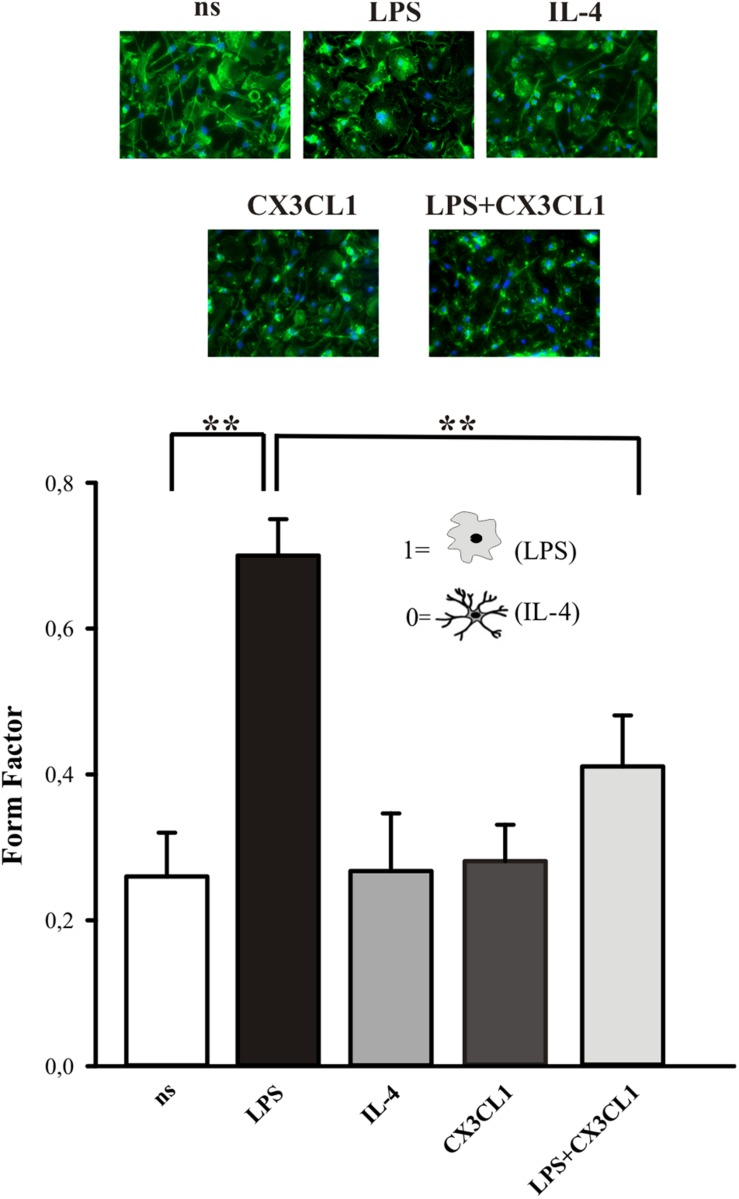
CX3CL1 induces change in microglia shape in culture. Upper panel: fluorescence images of microglia in culture stimulated with LPS, IL-4, CX3CL1, LPS + CX3CL1 and stained with Alexa-Fluor 488 Phalloidin. Lower panel: form factor analysis of microglia cells treated with LPS (pro-inflammatory stimulus) IL-4 (anti-inflammatory stimulus), CX3CL1, LPS + CX3CL1. Statistical analysis: Data are expressed as the mean (± SEM.) of n = 20 cells for each condition, ∗∗p < 0.001, Student’s t-test.